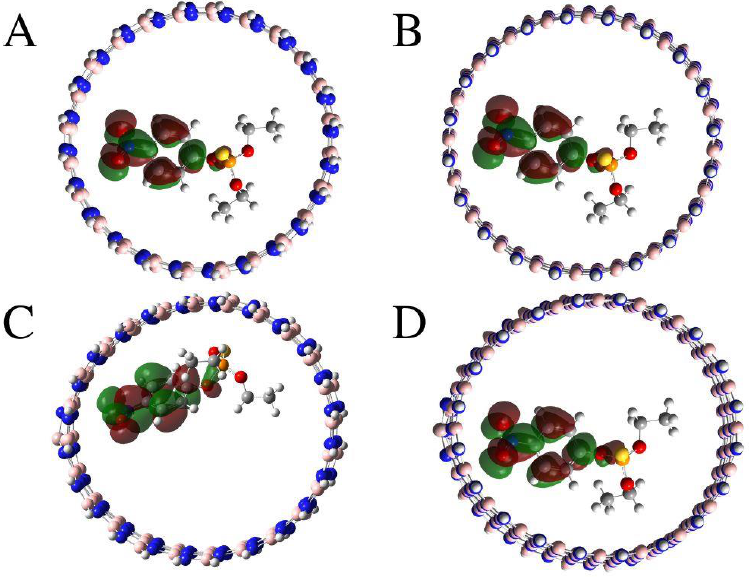
Figure 7. The LUMO diagrams of ( A ) BNNT(12,12) + par, ( B ) BNNT(20,0) + par, ( C ) Al-BNNT(12,12) + par, and ( D ) Al-BNNT(20,0) + par.